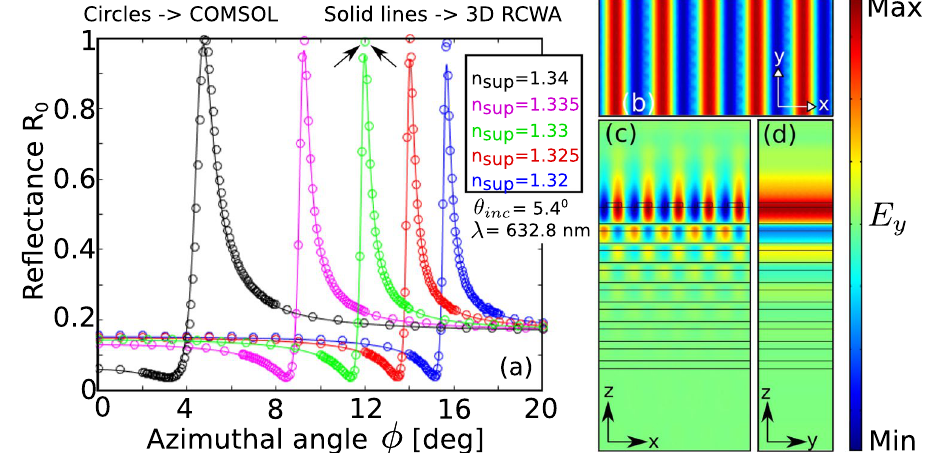
Figure 5. ( a ) Reflectivity curves as a function of azimuthal angle for different values of n sup . The wavelength ( λ ) and incident angle ( θ ) are fixed at 632.8 nm and 5.4° respectively. The results obtained using COMSOL (circles) and an in-house 3D RCWA code (solid lines) show good agreement. ( b ) x-y ( c ) x-z ( d ) y-z plane views of azimuthal BSW at the resonance peak indicated by the arrows in ( a